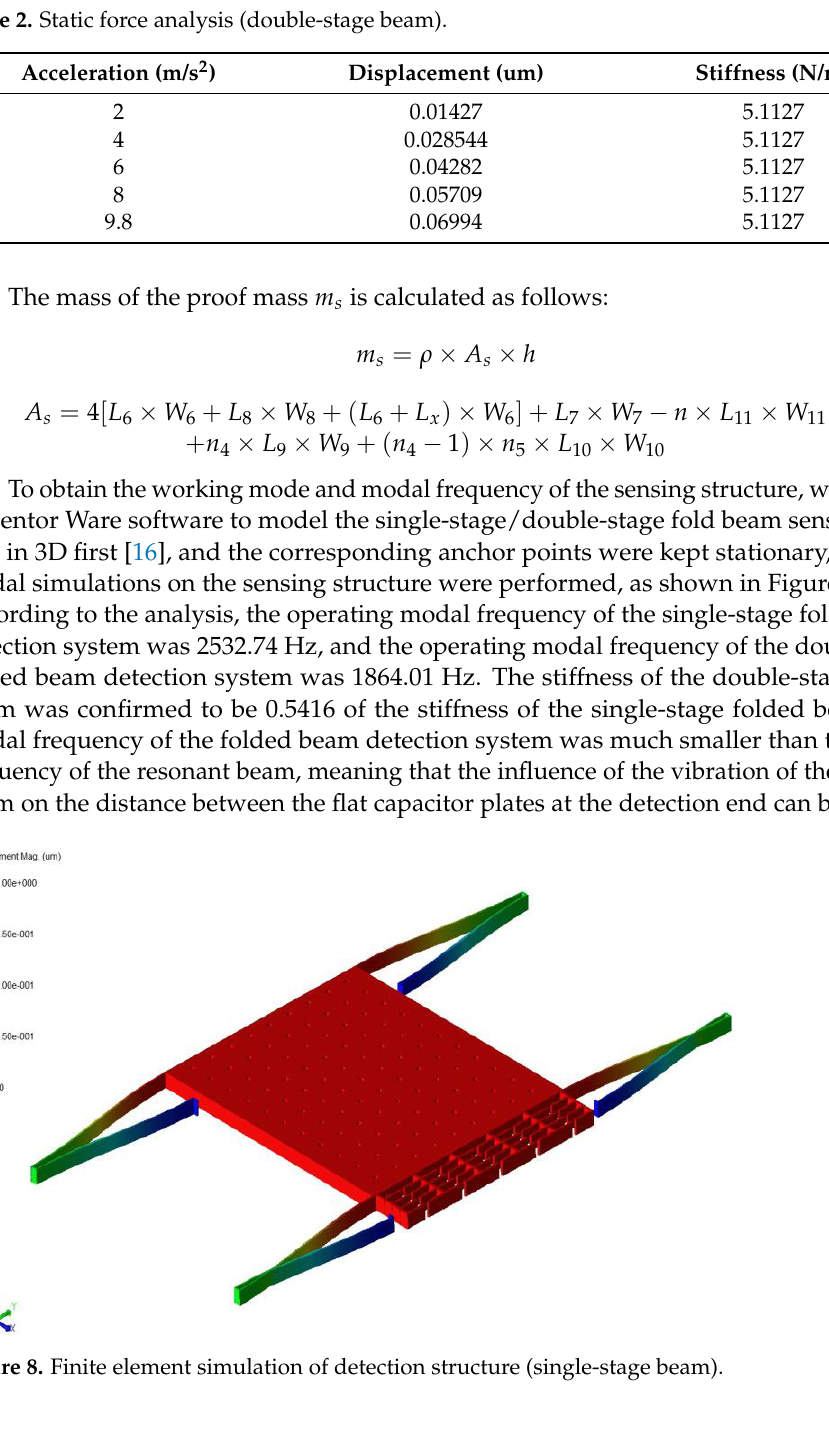
Figure 9. Finite element simulation of detection structure (double-stage beam).